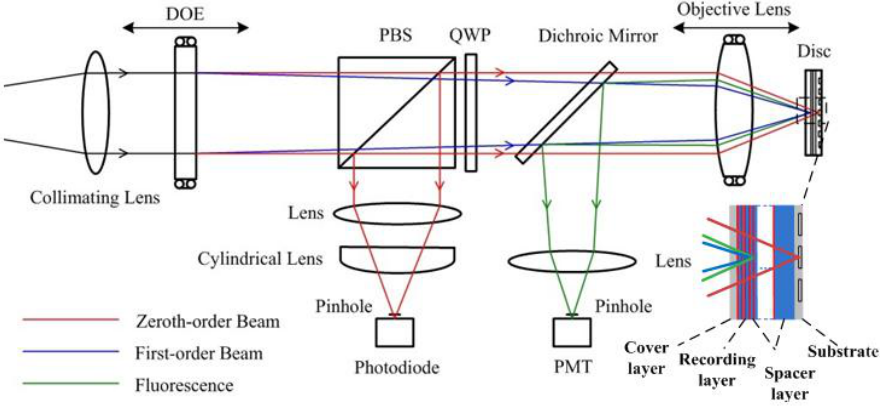
Figure 1. C onfiguration of the optical information storage sensing